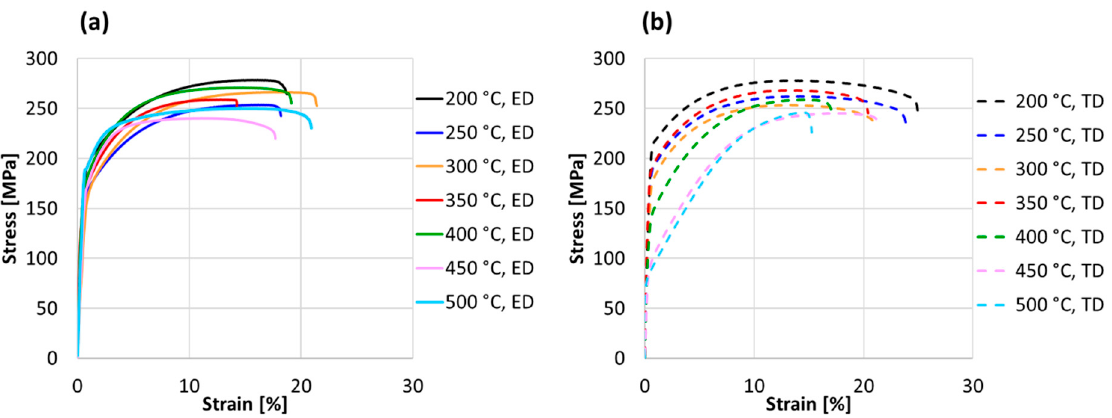
Figure 4. Engineering stress–strain diagram in ( a ) ED and ( b ) TD from the extruded flat bands. Table 3. Tensile properties at room temperature of the extruded bands tested along ED, TD (TYS, tensile 0.2% yield stress; UTS, ultimate tensile stress; ε u , uniform elongation; ε f , elongation to frac-